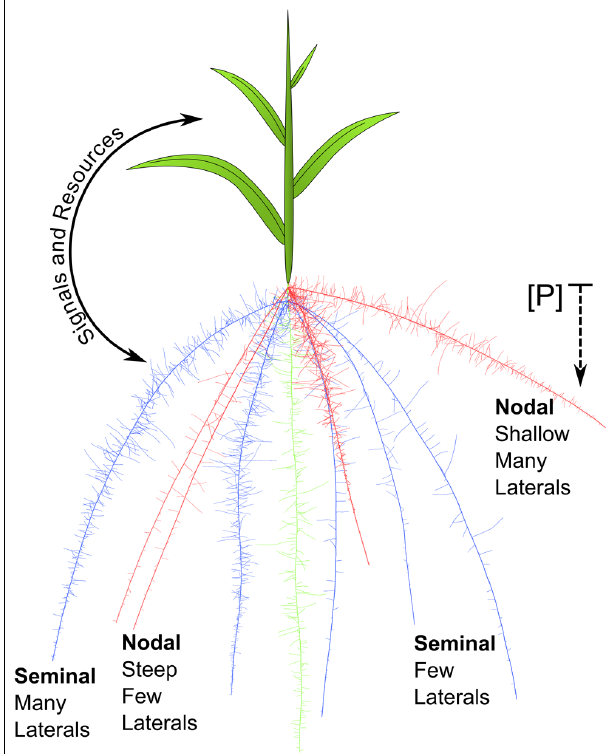
FIGURE 6 |A maize seedling is depicted. Seminal roots (blue) and primary root (green) emerge from the seed. One whorl of nodal roots (red) is shown emerging from belowground stem tissue.The nodal roots on the left have steep growth angles, while those on the right are shallow.The shallow nodal roots on the right also have dense laterals, while the steep nodal roots on the left have sparse laterals. In the context of phosphorus acquisition from the epipedon, shallow nodal roots with many laterals will have a synergistic interaction because they are acting within the same module.Though the seminal roots on the left have many laterals they will not interact synergistically for foraging with nodal root traits because they are in a different root class module.The whole plant is integrated by reciprocal signaling between shoot and roots and by balancing the production of photosynthates with soil resource